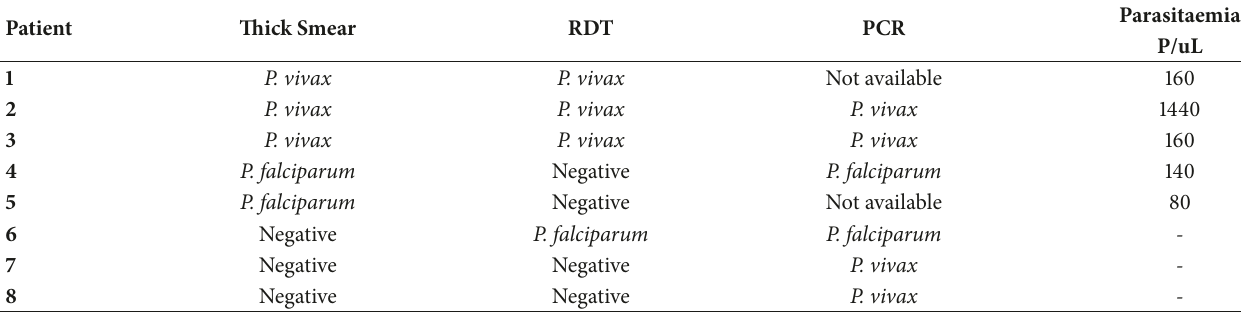
Table 3: Asymptomatic infections in Urab´a region diagnosed by microscopy and molecular